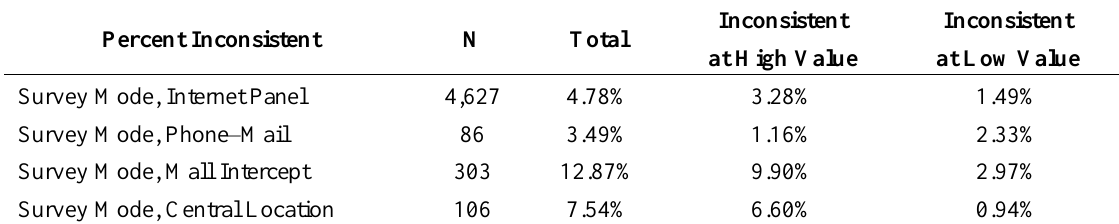
Table 5. Percent inconsistent responses by survey